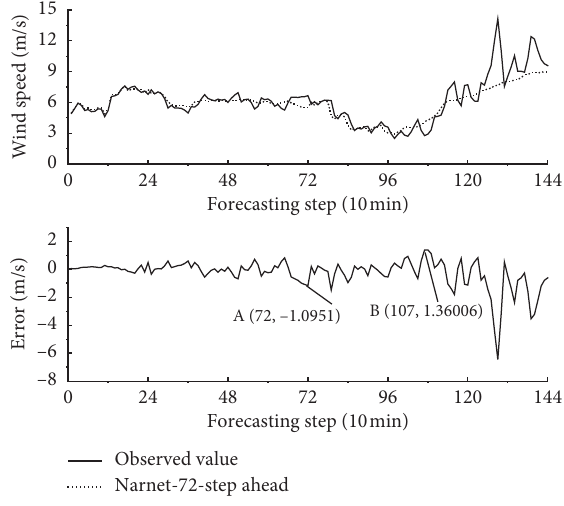
Figure 5: Verification result by Narnet. Table 3: Evaluation of different periods by the Narnet.